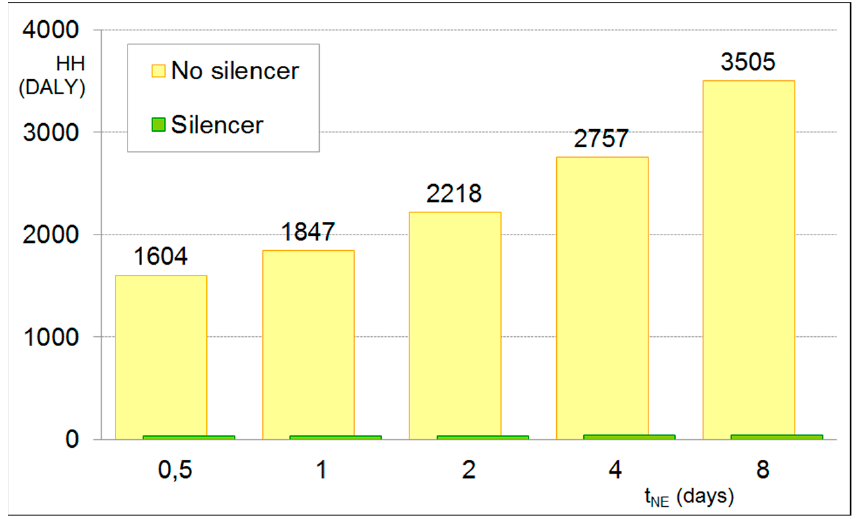
Figure 9. The relationship between HH indicator and steam discharge duration time.